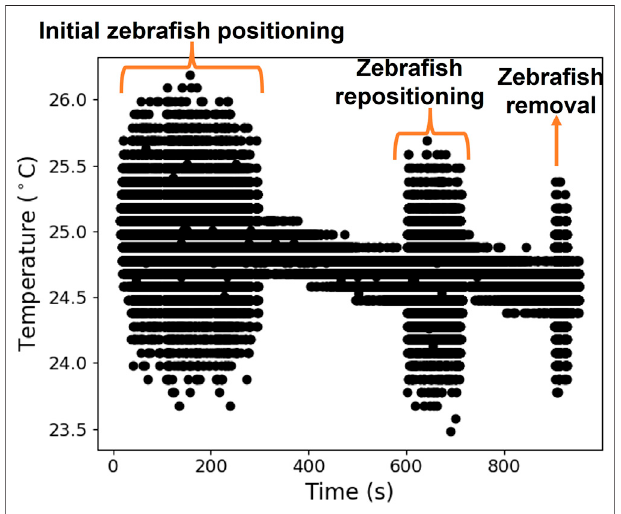
FIGURE 10 | Water temperature evolution during a zebra fi sh trial.